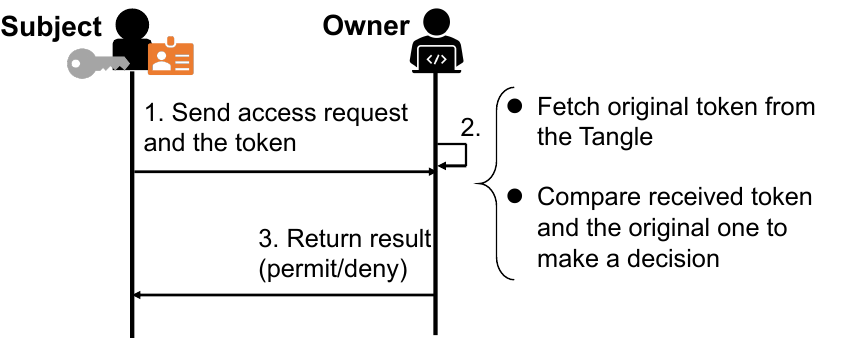
Figure 4. Access right verification